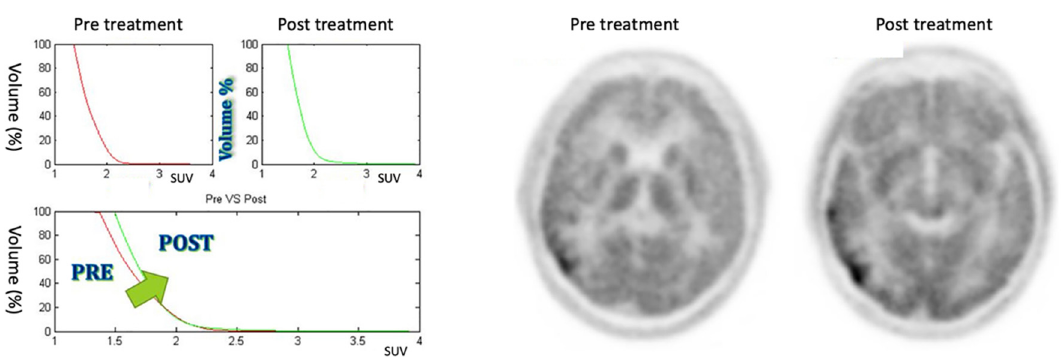
Figure 8. On the left: CSH pretreatment (top left); CSH post-treatment (top right); comparison between pre- and post-